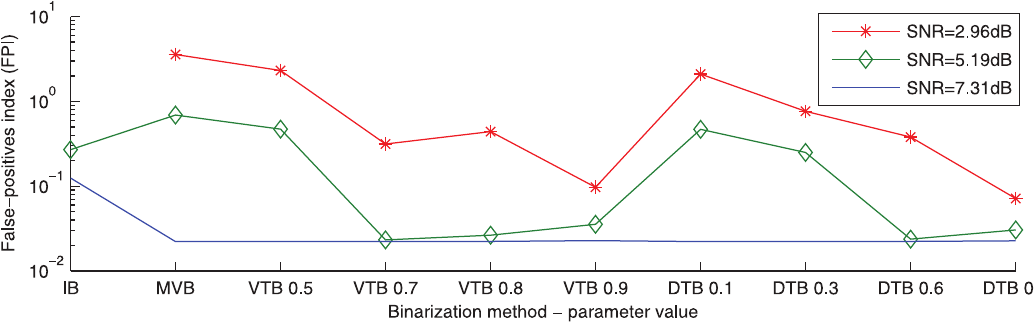
Figure 3. False-positives index ( FPI ). False-positives index ( FPI ) is plotted in log scale versus a subset of binarization configurations for three representative synthetic datasets out of 60. It should be noted that the binarization configurations are not entirely ordered according to their tightness.